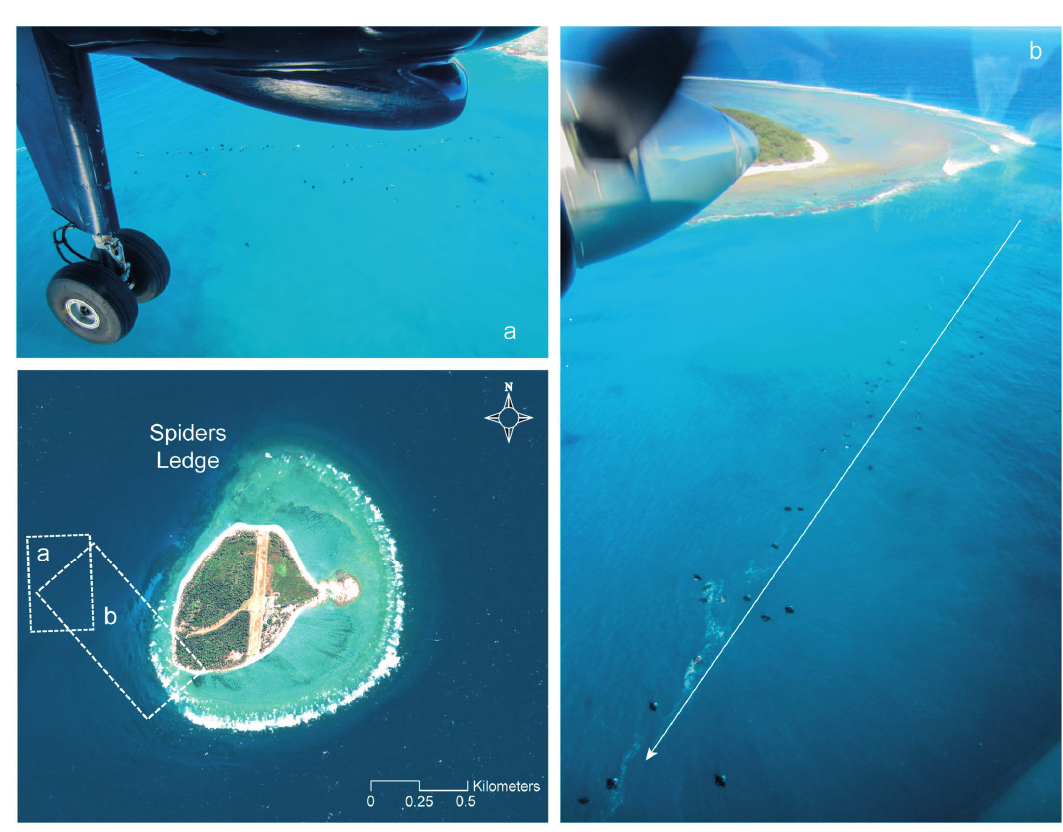
Figure 2. Aerial photographs of the reported manta ray feeding frenzy event on the western side of Lady Elliot Island (LEI) reef on 31 January 2013 at ~16h00. Spatial reference is provided by a Quickbird image of the study area (lower left panel). Dashed white boxes on the Quickbird image show the spatial extent of the associated photographs: ( a ) approaching LEI; and ( b ) feeding train of ~150 manta rays. The white arrow in (b) indicates the swimming direction of foraging manta rays. (Photographs courtesy of Bruce and Kate Laverty on Seair Pacific flight to